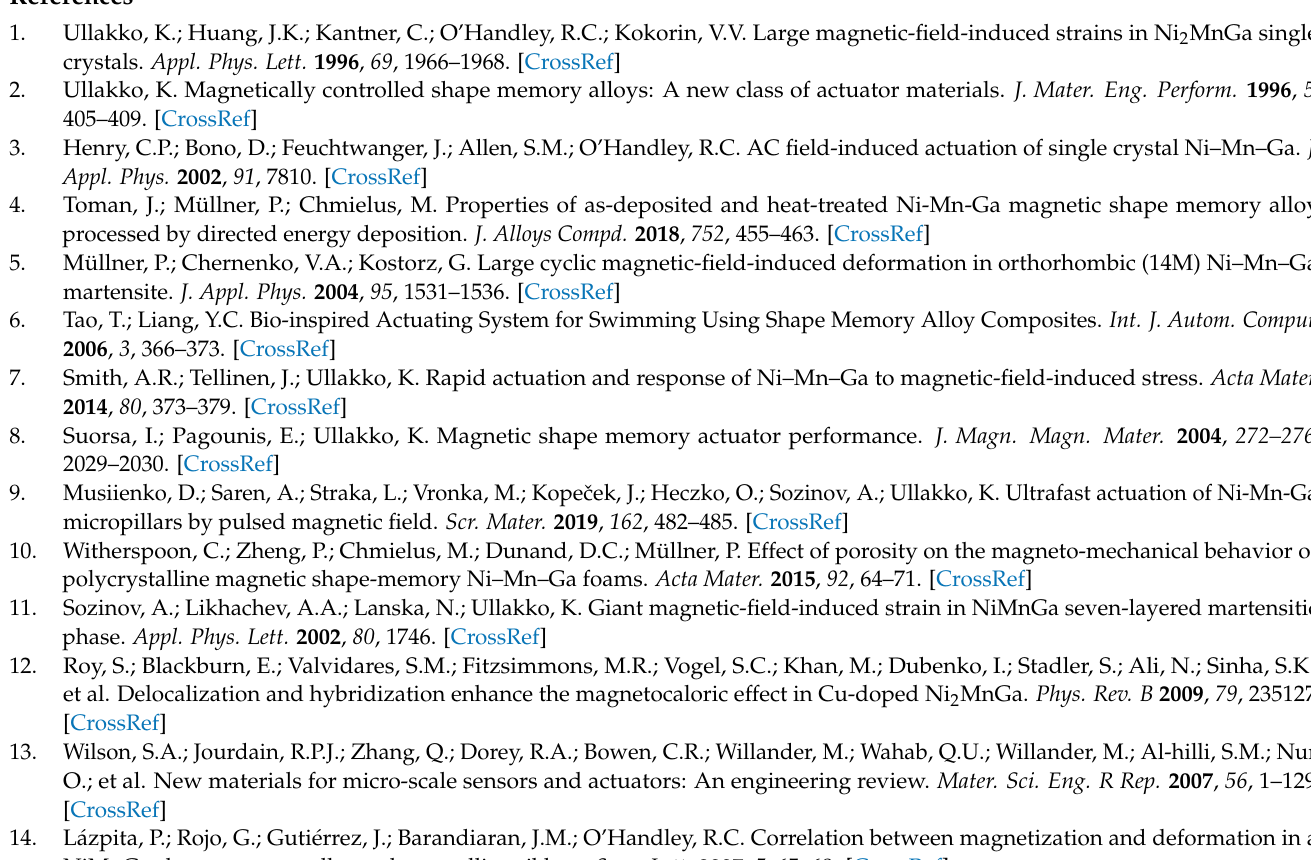
porosity; Figure S2: Example grain boundary tracing for grain size determination; Figure S3: Exem- plary SEM micrographs of nanoindentations of the 1080 ◦ C sintered only sample (a) with and (b) without twin boundary